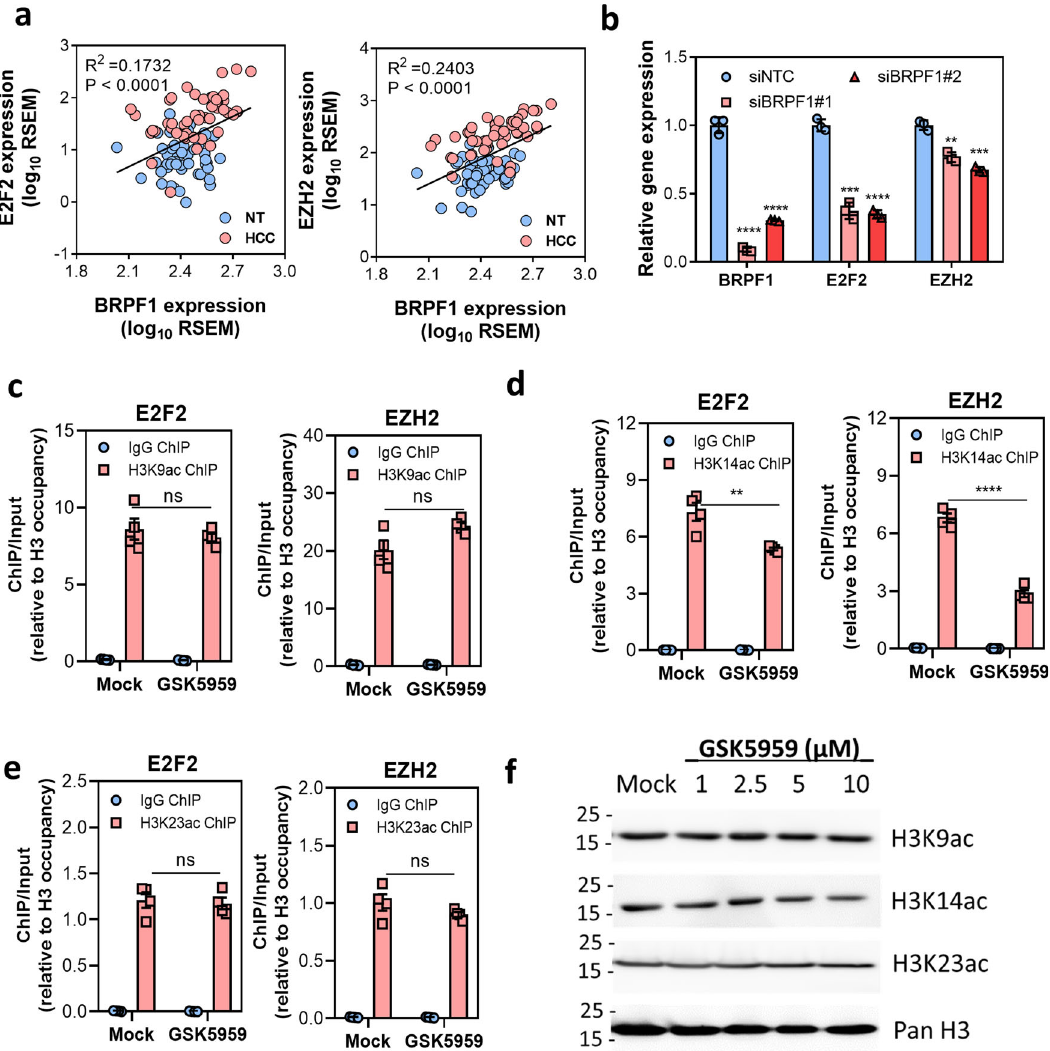
Fig. 8 BRPF1 regulated the expression of downstream targets through epigenetic modi fi cation. a BRPF1 expression was positively correlated with the expression of E2F2 ( R 2 = 0.1732, P < 0.0001, linear regression) and EZH2 ( R 2 = 0.2403, P < 0.0001, linear regression) respectively in TCGA HCC cohort. n = 50 b The mRNA expression of E2F2 and EZH2 was reduced in MHCC97L cells siRNA-mediated BRPF1 knockdown. c H3K9 acetylation levels at the promoters of E2F2 and EZH2 remained unchanged after 48-h of GSK5959 treatment in MHCC97L cells. d H3K14 acetylation levels at the promoters of E2F2 and EZH2 were reduced upon 48-h of GSK5959 treatment in MHCC97L cells. e H3K23 acetylation level at the promoters of E2F2 and EZH2 remained unchanged after 48-h of GSK5959 treatment in MHCC97L cells. All acetylation levels were normalized by histone H3 occupancy level. f GSK5959 had no effect on the global levels of H3K9, H3K14, and H3K23 acetylation in MHCC97L cells after 5-days treatment. Error bars indicate mean ± SD. Data were compared by independent t- test unless indicated otherwise. Results were repeated at least three times. ** P < 0.01, *** P < 0.001, **** P < 0.0001, ns not signi fi cant vs siNTC or IgG ChIP as